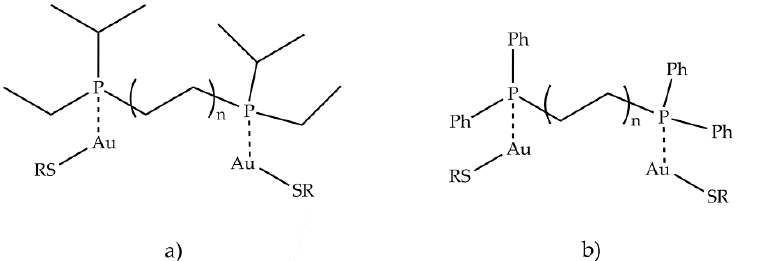
10 of 15 Figure 8. Chemical structure of ( a ) cis platin and ( b ) auranofin. A good cytotoxic activity was also evaluated in vivo against P388 lymphocytic leukemia implanted in mice [81]. Several gold (I) thiolates have been tested for their anticancer activity. Aurothioglucose (Figure 9a) and aurothiomalate (Figure 9b) inhibited primary tumor growth in mice with Lewis carcinoma and reduced lung metastases [81]. Unlike cis platin (6), aurothiomalate did not exhibit acute toxicity in vivo. Figure 9. Chemical structure of ( a ) aurothioglucose and ( b ) sodium aurothiomalate. The in vitro cytotoxicity of several gold compounds against B16 melanoma and P388 leukemic cells was examined in a study of auranofin and similar compounds [81]. The result shows that a wide variety of gold (I) phosphine thiolates possesses a significant cytotoxic activity. The presence of a phosphine or arsine as a binder has resulted in an